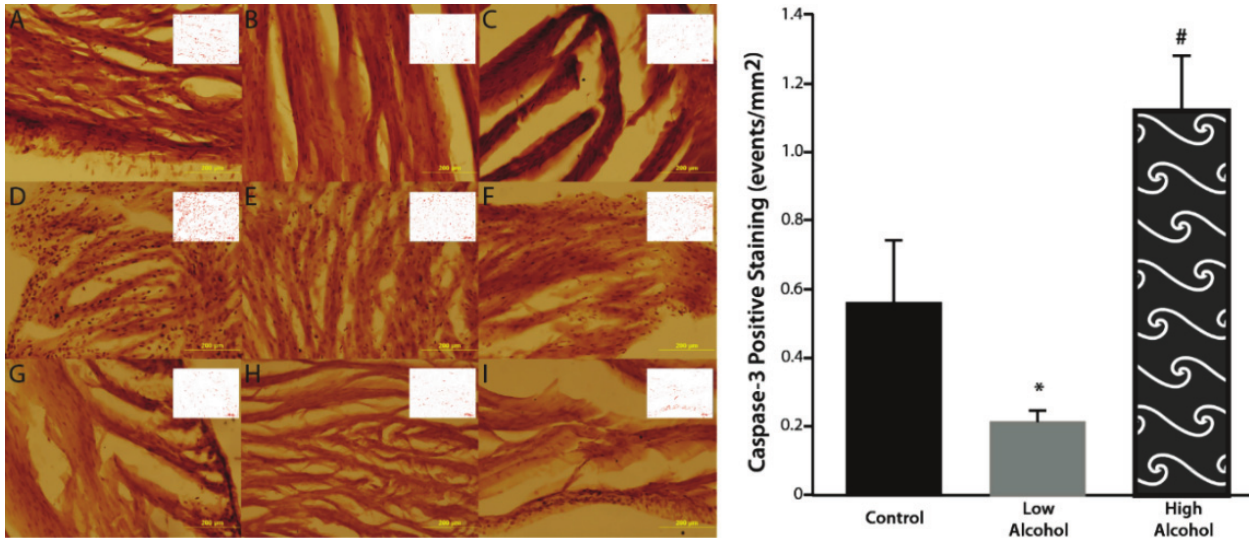
Figure 1. Chronic high alcohol ( G – I ) results in a thinning of the left ventricular wall accompanied by an enlargement of the ventricular lumen compared to age-matched and pair-fed chronic low alcohol ( D – F ) and control subjects ( A – C ). Magnifications of 1.25× ( A , D & G ) 10× ( B , E & H ) and 20× ( C , F & I ) are displayed above; scale bars = 5 mm, 500 (cid:2)m, and 200 (cid:2)m respectively.